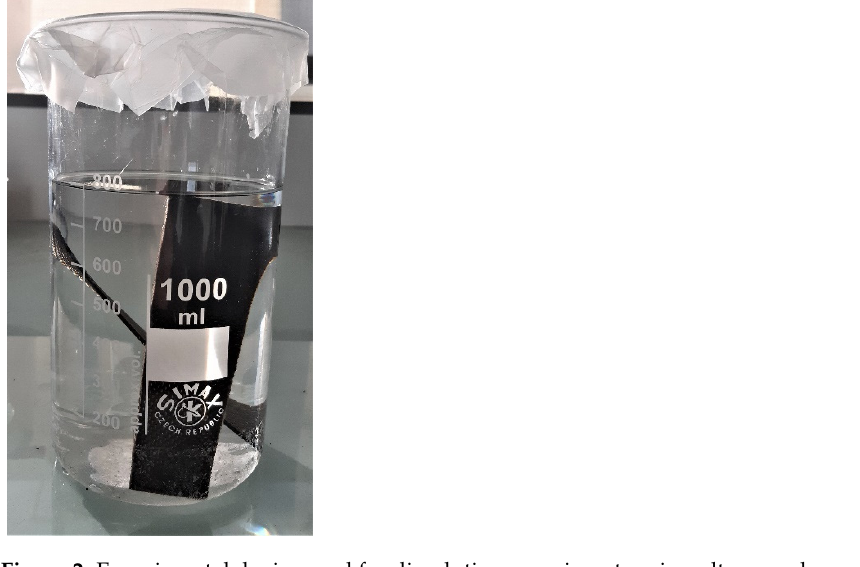
Figure 2. Experimental device used for dissolution experiments using ultrasounds.